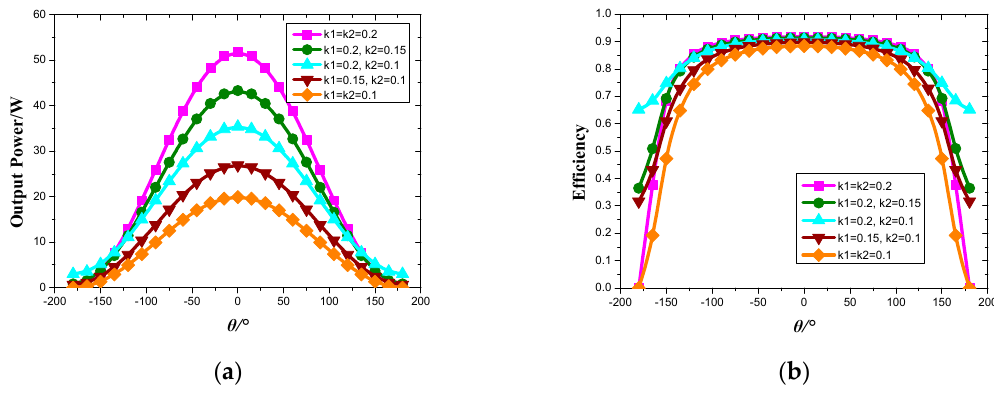
Figure 9. Curve of output power and efficiency with phase shift: ( a ) Curve of output power with phase shift; ( b ) Curve of efficiency with phase shift.